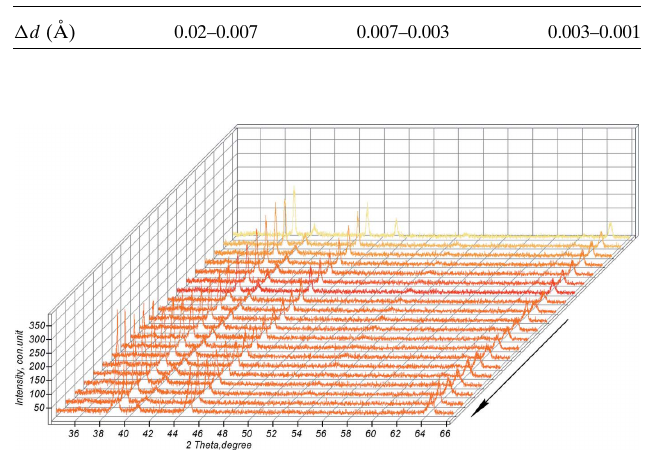
Figure 8 The sector of powder mixture heating during high-temperature synthesis (the arrow indicates the direction of the reaction).